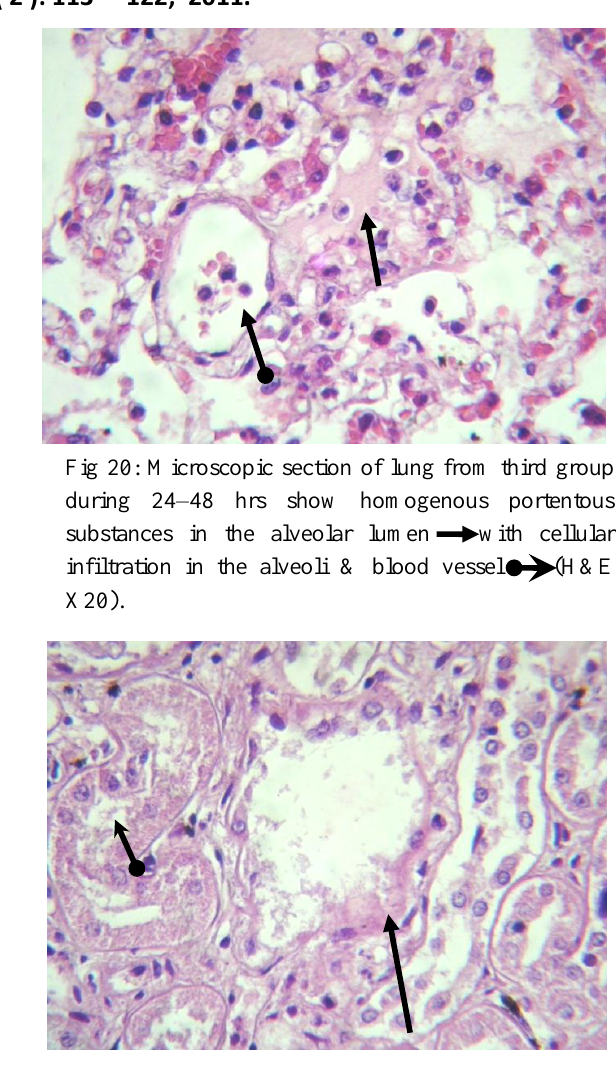
Fig 22: Microscopic section of kidney from third group during 24-48 hrs show cellular swilling with sloughing& necrosis of epithelial lining tubule. (H&E X40).